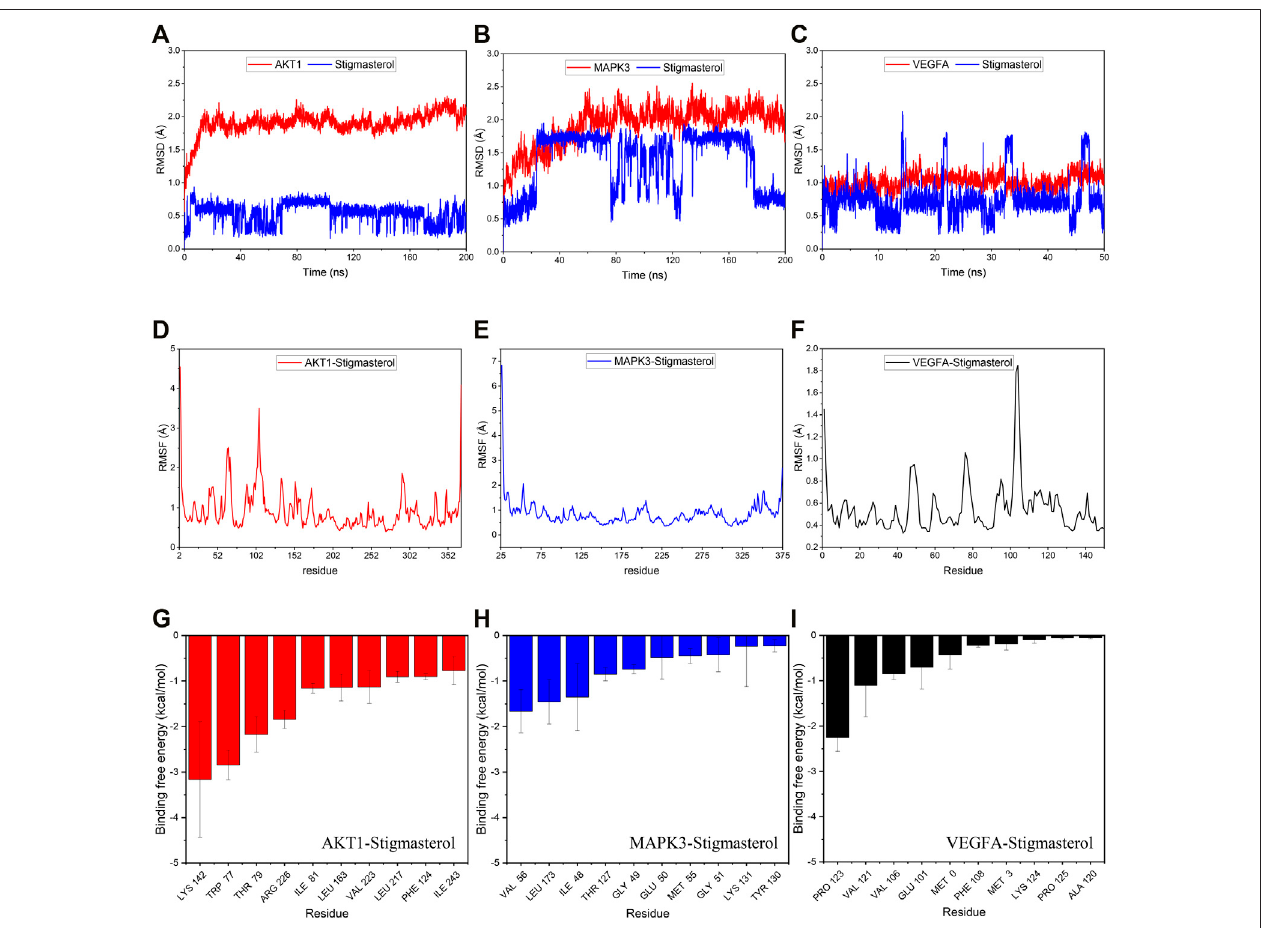
FIGURE 7 | RMSD, RMSF and residue decomposition plot during molecular dynamics simulations. (A – C) The RMSD of AKT1-stigmasterol, MAPK3-stigmasterol and VEGFA-stigmasterol. (D – F) The RMSF of AKT1-stigmasterol, MAPK3-stigmasterol and VEGFA-stigmasterol. (E – I) The residue decomposition of AKT1- stigmasterol, MAPK3-stigmasterol and VEGFA-stigmasterol. The contribution of top 10 residue to bind was presented.